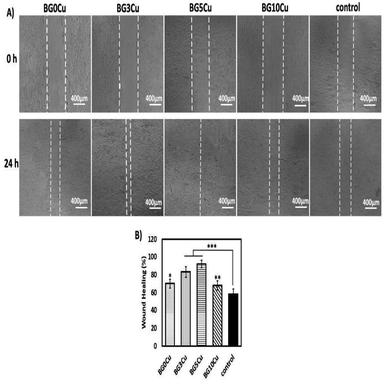
human umbilical vein endothelial cells migration after 1 day of incubation with the modified bioactive glasse extracts. (A) The monolayer of human umbilical vein endothelial cells was scratched with the tip of a 100 ml pipette. The position of the primary wound edge at the start of the experiment and after 1 day of incubation with various extracts of the modified bioactive glassesand culture media is represented with dashed lines. (B) The percentage of wound repair after 1 day was compared to the initial sp